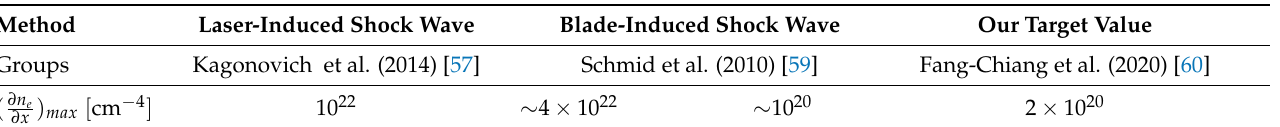
Table 1. The maximum gradients of the electron number densities obtained from different groups. Our target value is also shown.